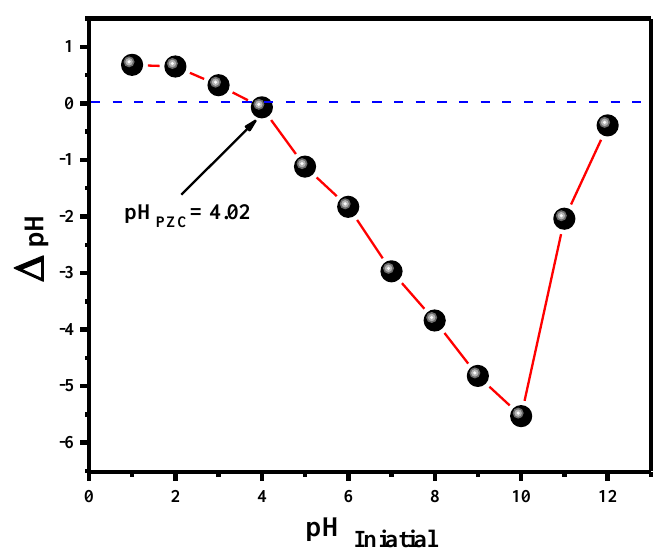
Figure 4. pH zero charge of the V@TiO 2 nanocomposite.